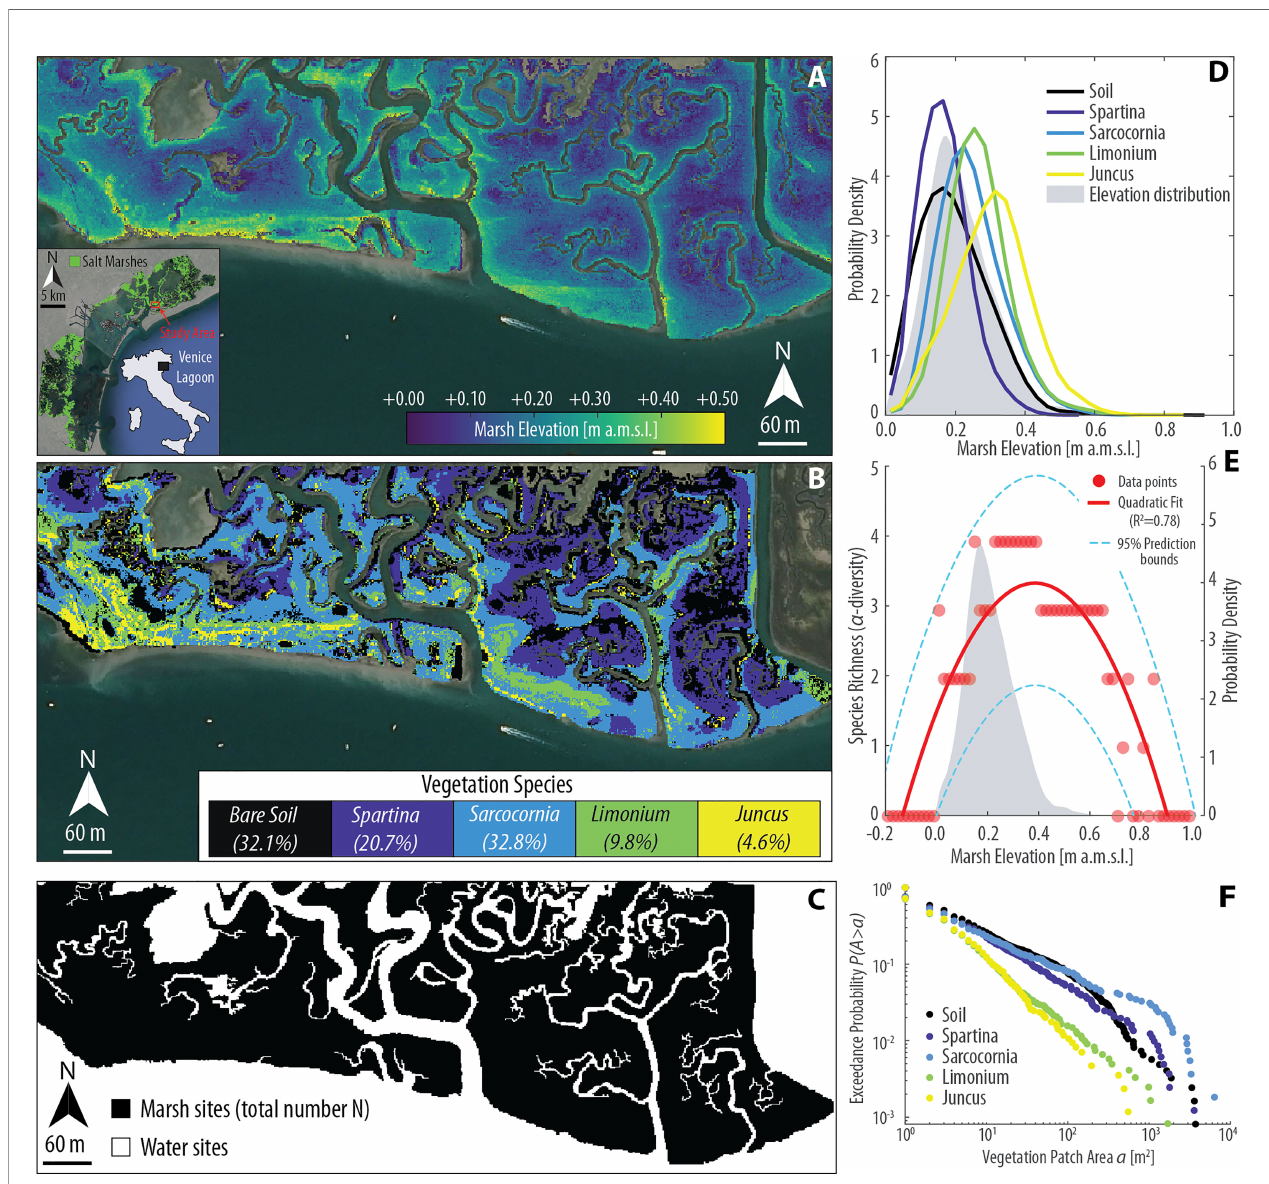
FIGURE 1 | Topographic gradients and vegetation zonation in the San Felice salt marsh (Venice Lagoon, Italy). (A) Lidar-derived digital elevation model (DEM, spatial resolution 1 m; mean elevation 0.21 ± 0.09 m above datum) superimposed to an aerial image of the study area (Aerial Imagery ©CNES/Airbus). Lidar data were collected on February 9, 2003. The reader is referred to Wang et al. (2009) for further details regarding data acquisition. (B) Classi fi cation map of vegetation species in the study area. The classi fi cation was carried out utilizing a Compact Airborne Spectral Imager (CASI) image, acquired on 29 th September 2002 with a spatial resolution of 1.3 m from a fl ight altitude of 840 m (Belluco et al., 2006; Wang et al., 2007). Dominant vegetation species within each pixel were obtained based on relative fractional abundance estimated through the Random Forest soft classi fi cation method (see Yang et al., 2020b for further details), and upsampled using a bicubic interpolation method to meet the resolution of the Lidar data. The percent vegetation cover for each vegetation class is also reported in the legend. (C) Binary representation of the computational domain employed in the numerical simulations presented in this study. (D) Realized ecological niches observed in the study area based on DEM and vegetation data shown in panels (A, B) , respectively. Continuous lines represent the probability density estimates of each species (including bare soils) across marsh elevations, whereas the gray area denotes the probability density estimates of marsh elevation derived from DEM data. (E) Local species richness (i.e., a -diversity) as a function of marsh elevation. Red dots represent point data derived from the DEM and vegetation map shown in panels (A, B) , respectively. Red line denotes the best quadratic fi t to point data, with dashed blue lines showing 95% prediction bounds. The gray area denotes the probability density estimates of marsh elevation derived from DEM data. (F) Empirical probability distributions of spatially-continuous vegetation patch areas, for different species including bare soil, are shown based on the exceedance probability for a given vegetation patch size. The analysis is based on vegetation data shown in panel (B) . Empirical probability distributions of patch area are derived by computing A for every vegetation patch and plotting the probability obtained by counting the relative proportion of patches of the same species whose total area exceeds a current value a , here expressed in square